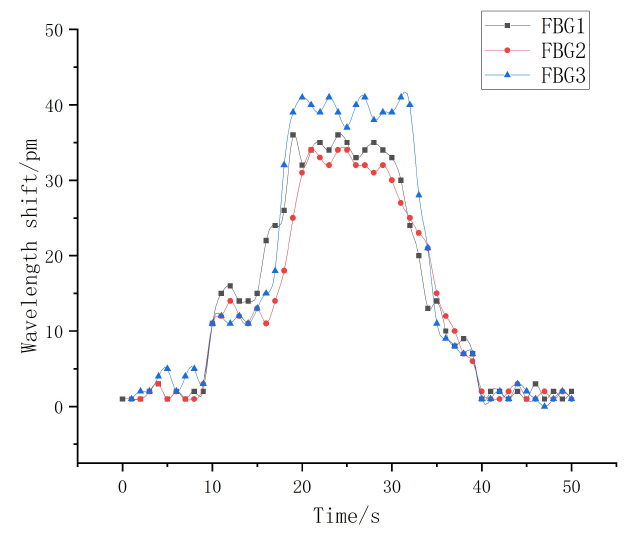
Figure 28. Central wavelength shift diagram of three